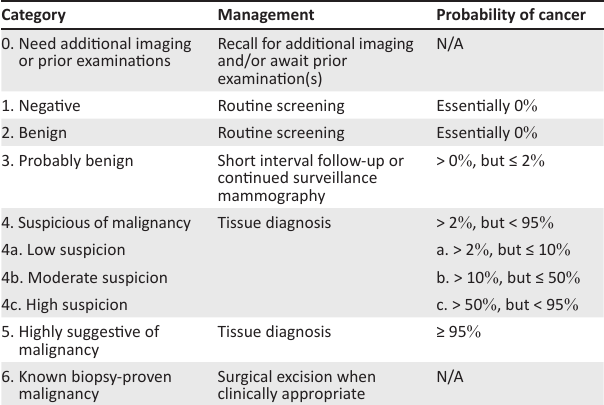
TABLE 1: American College of Radiology breast-imaging reporting and data system final assessment categories. Category Management